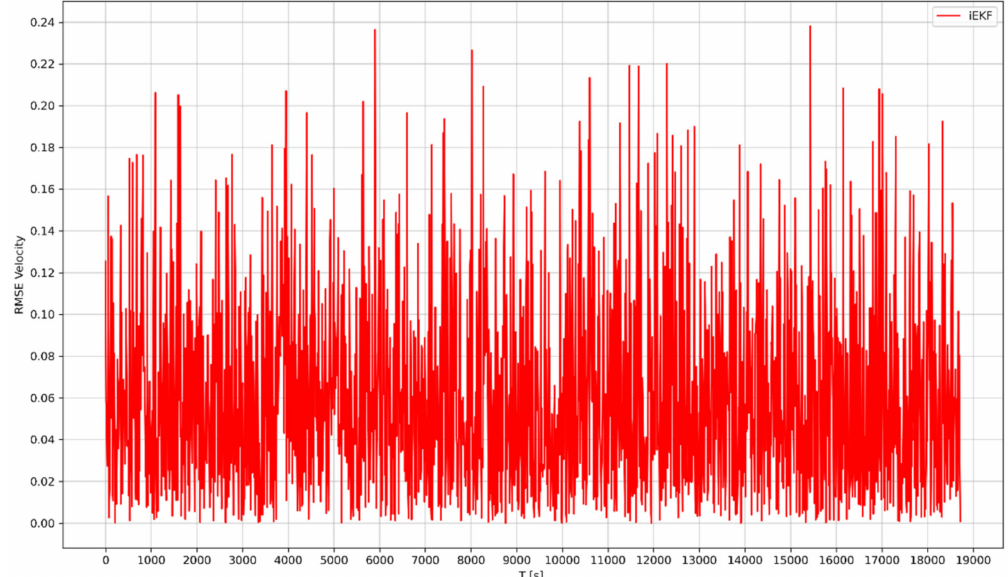
Figure 17. Case 2: iEKF RMSE for the